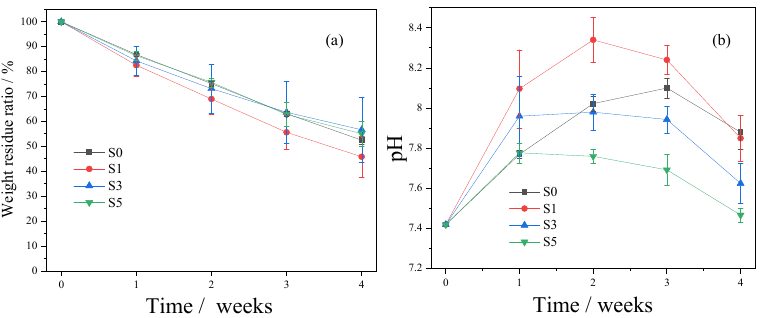
Figure 7. In vitro degradation of porous composite scaffolds. ( a ) Weight residue ratios of scaffolds; ( b ) pH values of Tris-HCl at the set time points.